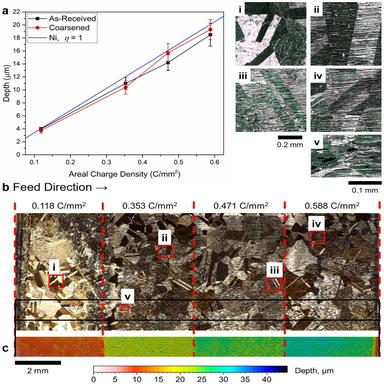
Electrochemical jetting approaches to step profiling. a) Removal depth is independent of precondition, proceeding at high current efficiency. Blue series calculated from Faraday's law (Eq.). Error bars are the average deviation from the line of best fit across the average depth of the central region (1.5 × 8.5 mm) of each processed layer. b) Optical micrograph (unpolarised light) of EJM large-area etch surface in coarsened Ni, showing optical grain contrast, indicative of the underlying topograp